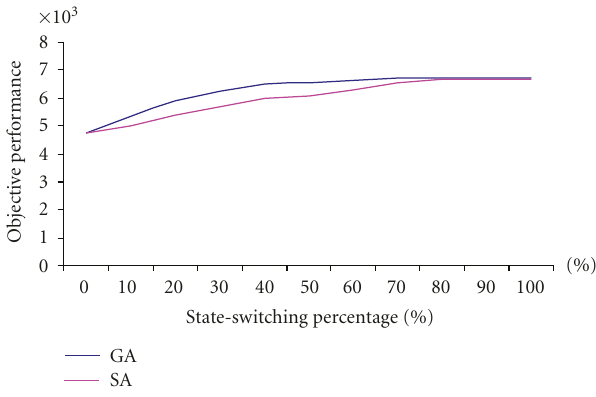
Figure 17: E ff ect of sensors’ reliability with di ff erent numbers of sensors on the coverage performance of GA.